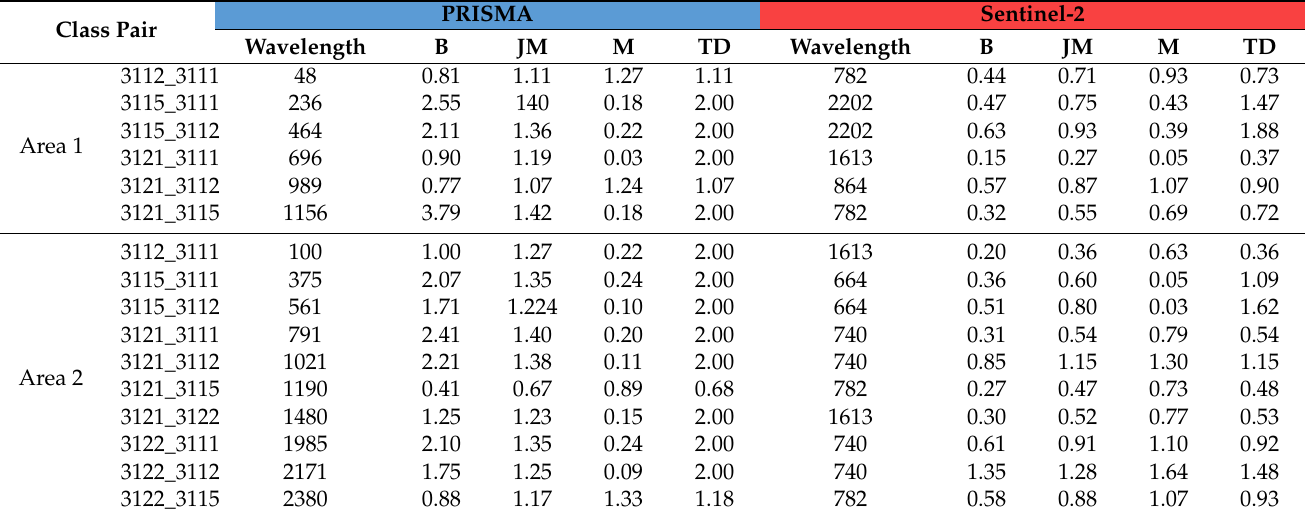
Table 4. Best separability for each pairwise combination. In blue, the PRISMA sensor; and in red, the Sentinel-2 sensor. The number represents the wavelength where the highest separability was obtained. B for Bhattacharyya distance, JM for Jeffries–Matusita distance. M for M-Statistic, and TD for Transformed Divergence.